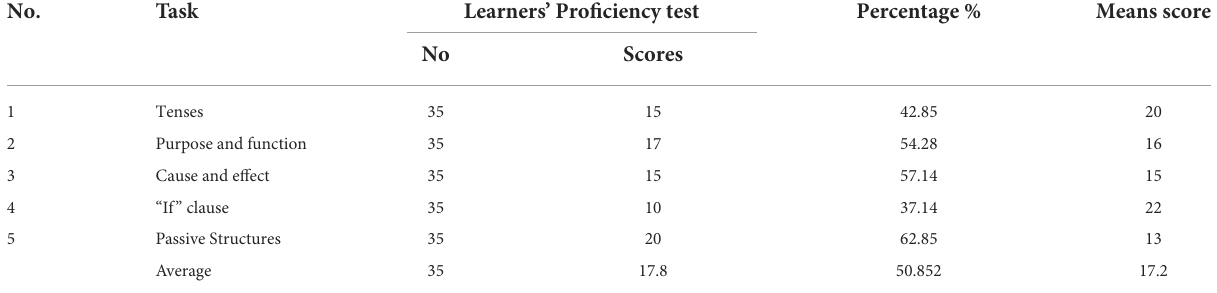
TABLE 2 The learners’ ability in each grammatical